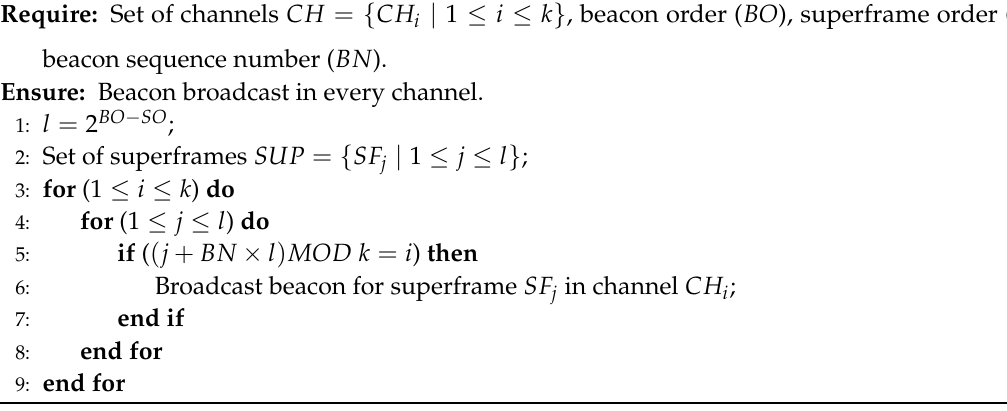
Algorithm 1 A new beaconing scheme for